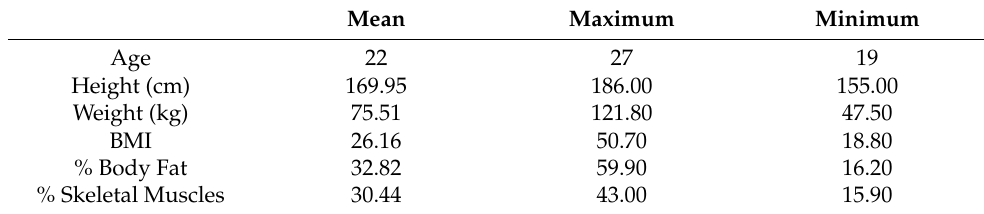
Table 3. Characterisation of the volunteers from